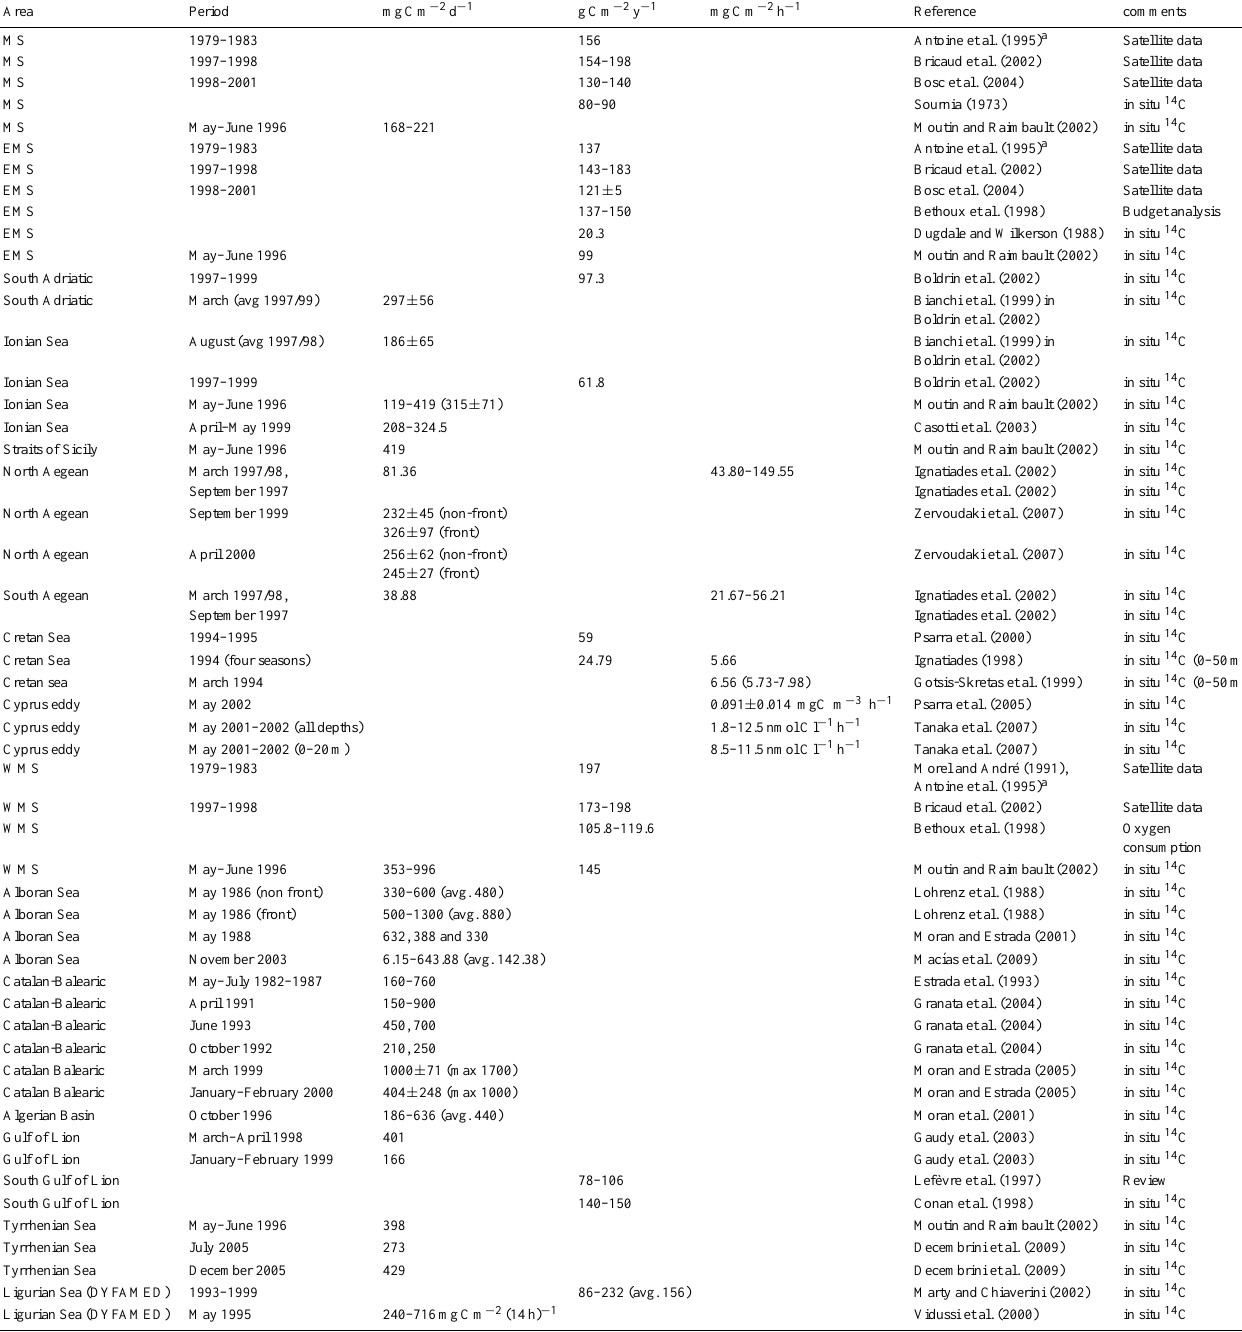
Table 1. Values of primary production reported for the